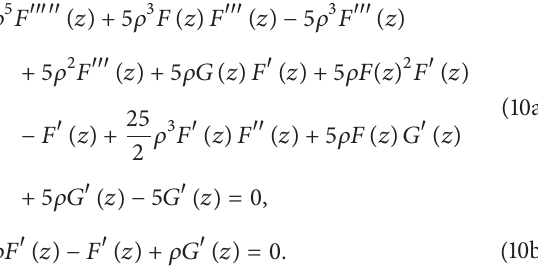
Solving the resultant system of algebraic equations,